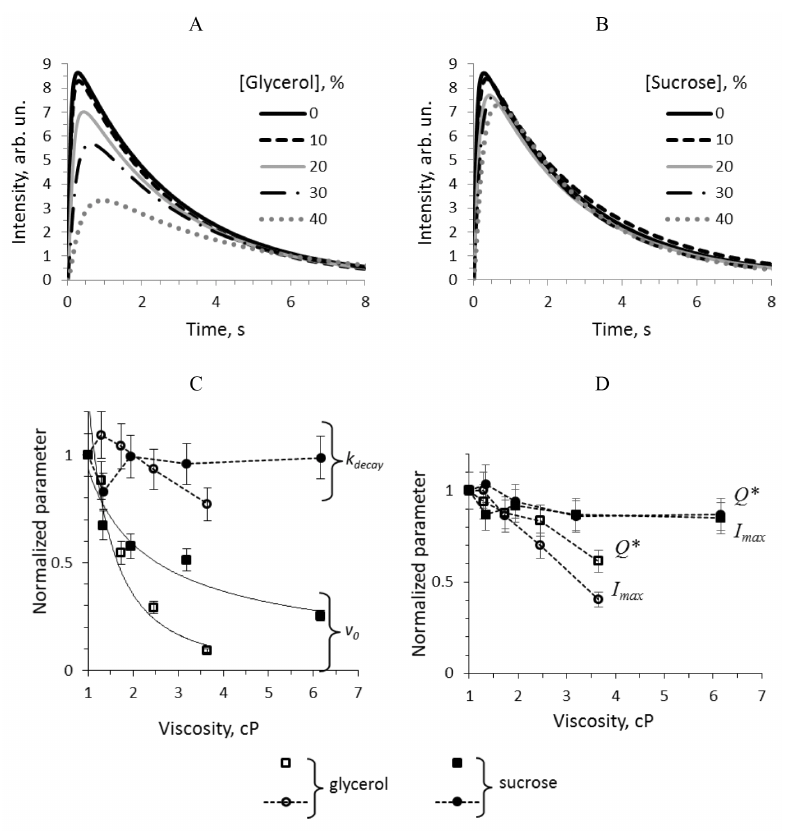
Figure 2. The kinetic curves of the bioluminescent reaction with 40 µ M of decanal in media with 10, 20, 30 and 40% of glycerol ( A ) and sucrose ( B ) and dependence of their characteristics on the media viscosity: the decay constant and initial velocity ( C ); the peak intensity and the total quantum yield ( D ). The parameters were normalized in accordance with the values in the buffer (viscosity of 1 cP). The solid lines are the power law approximation with the exponent − 0.67 for sucrose solutions and − 1.85 for glycerol ones. The dashed lines are shown to guide the